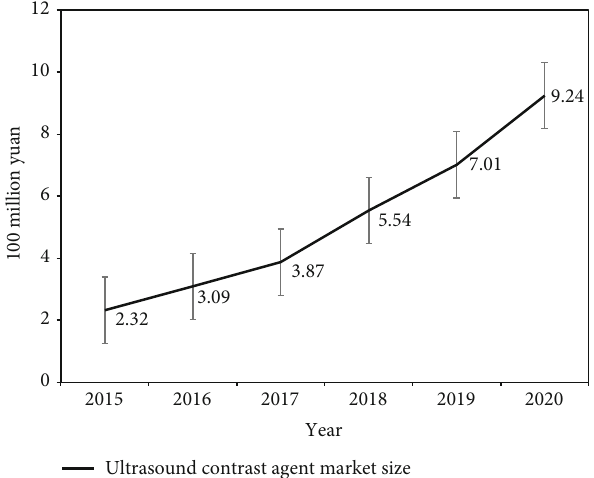
Figure 6: Market size of ultrasound contrast agents in my country in recent